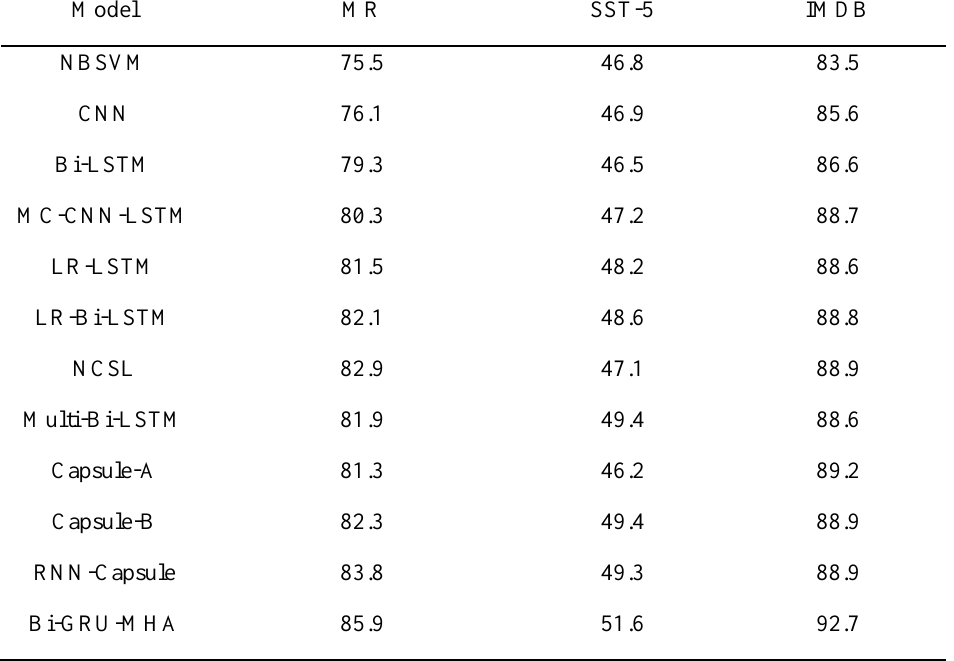
Table 3. Experiments results of